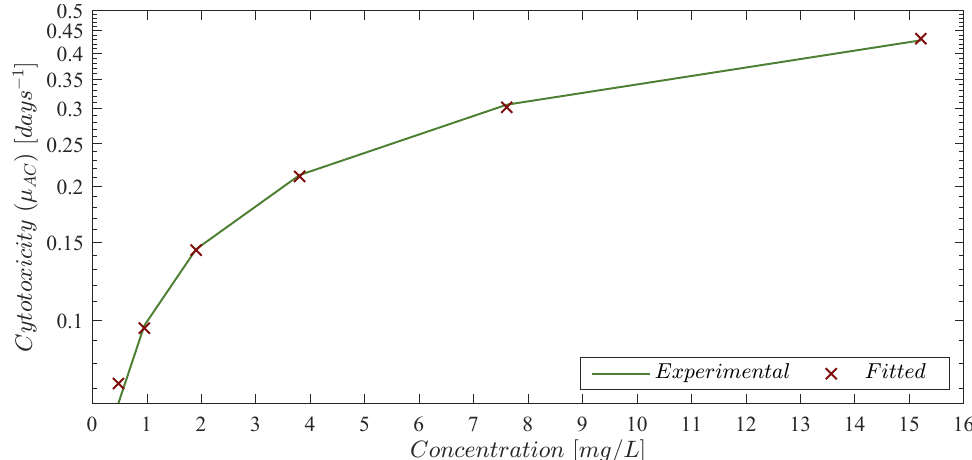
Experimental Fitted